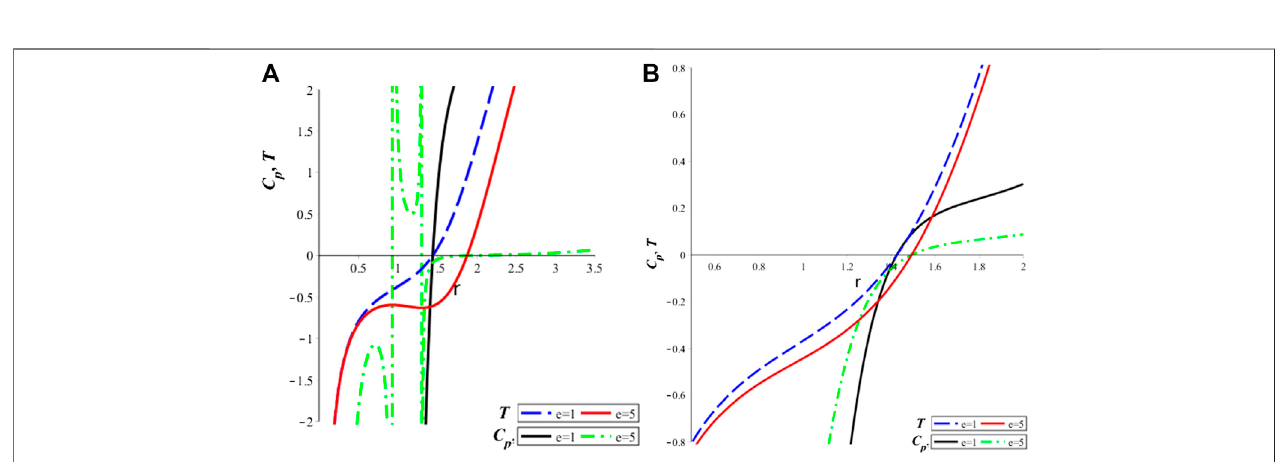
FIGURE6| Isenthalpiccurvesand inversion curveofthePMquasitopologicalblack holewith (cid:5) μ 2 (cid:1) 0 . 1, (cid:5) μ 3 (cid:1) 0 . 1, (cid:5) μ 4 (cid:1) 0 . 001, k (cid:1) 1, n (cid:1) 4and q (cid:1) 1 (A) S (cid:1) 0.7, (B) S (cid:1) 1.4.